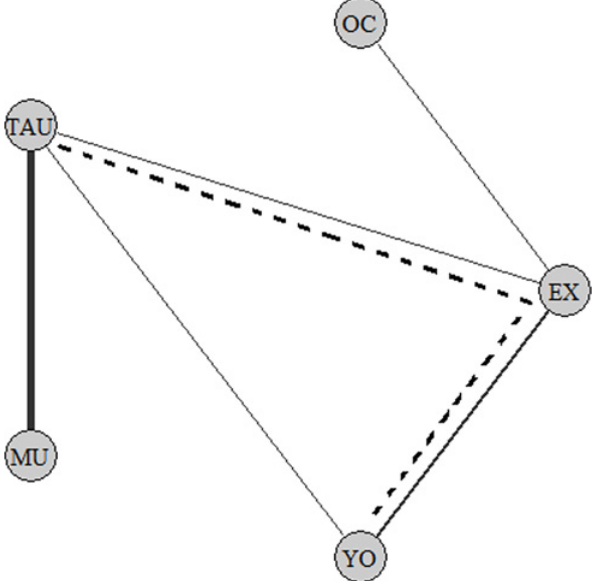
Fig 2. Network model of included studies. (A) MU, Music Therapy; TAU, Treatment As Usual; YO, Yoga Therapy; EX, Exercise Therapy; OC, Occupational Therapy. (B) When therapies are connected with an un- interrupting line, they have been directly compared in an RCT (for example, between YO and TAU). (C) The thickness of lines represent the number of studies that investigated this comparison. (D) An indirect comparison between YO and TAU is demonstrated by the dotted line. The comparison YO and TAU can be indirectly estimated via the loop YO to EX, from EX to TAU.